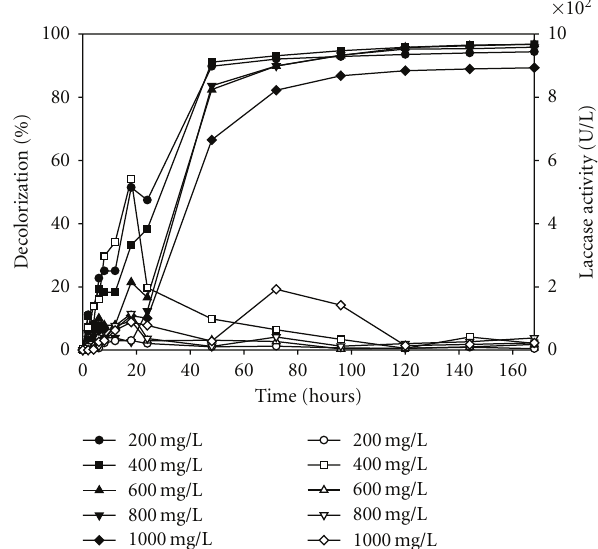
Figure 2: The e ff ect of reactive RB5 dye concentrations on %decolorization and Lac activity after cultivation with Datronia sp. KAPI0039; close symbol = %decolorization; open symbol = Laccase